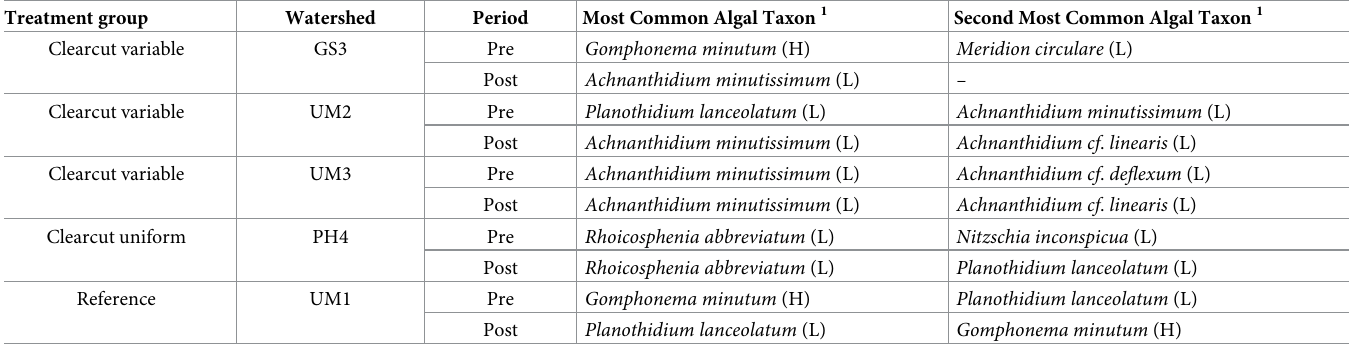
Table 4. The most common and second most common algal taxa in selected headwater streams, based on cell counts of epilithon samples. Treatment group